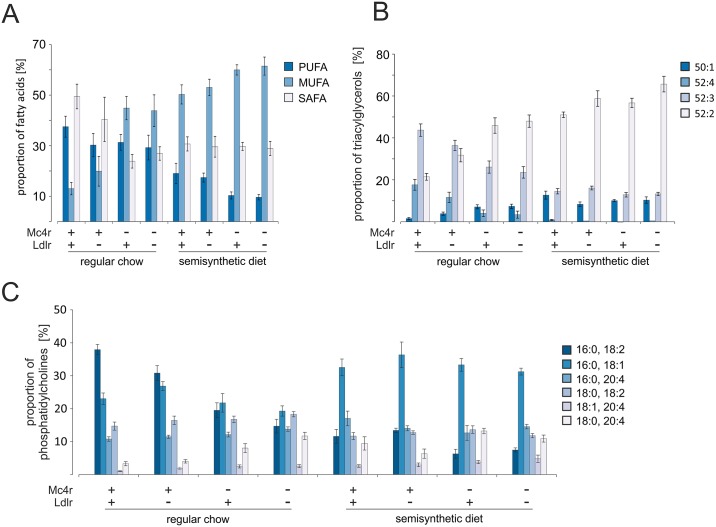
Contents of saturated and unsaturated fats in livers of wild-type and genetically modified mice.(A) The average percentage of PUFAs, MUFAs and SAFAs determined from the 1H HR MAS NMR spectra is shown for the indicated mouse strains. (B) The relative composition of TAGs was determined by positive ion MALDI-TOF MS. Minor TAGs, which are not included in this figure, are given in the S2 Table. (C) The relative PC composition was determined by MALDI-TOF mass spectrometry. Minor PC species not included in this chart are given in S2 Table. All data are given as mean ± SEM. For all statistical comparisons, a Kruskal-Wallis test was performed. Detailed information on p-values are given in S2 Table (n = 8–9).